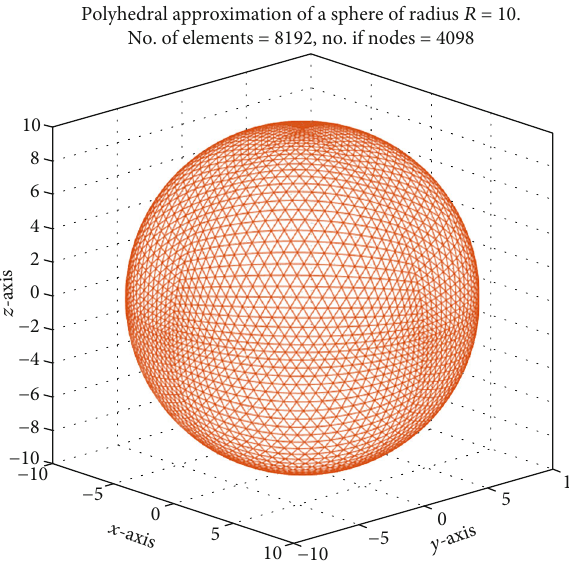
Figure 2: A polyhedral approximation of a sphere of radius R = 10